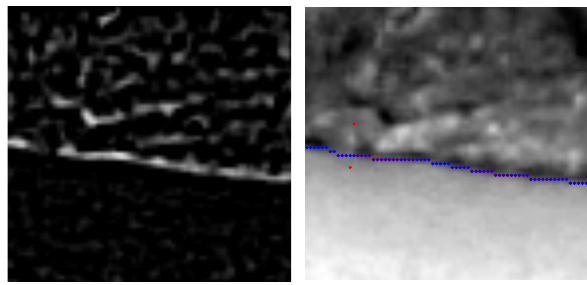
Figure 6. LoG filtered image; median filtered water line (blue) and outliers (red) in sequence image (left to right).